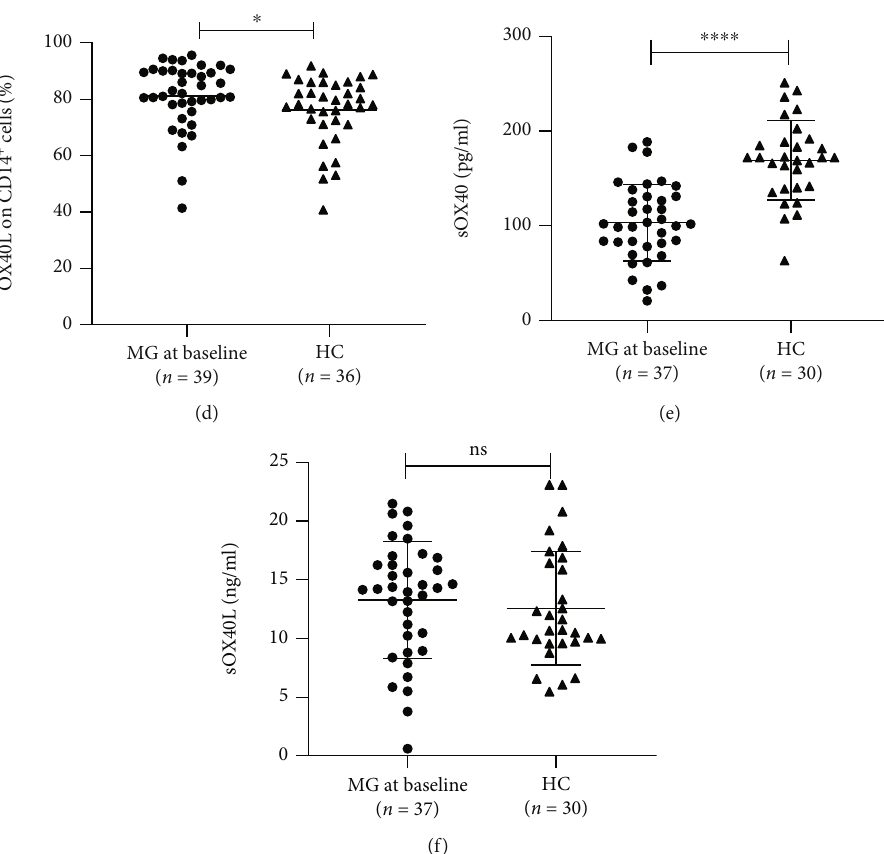
Figure 1: OX40/OX40L expression on the peripheral blood lymphocytes and plasma of patients with MG at baseline. (a) Representative expression of OX40 on CD4 + T cells and OX40L on CD19 + B cells and CD14 + mononuclear cells in the patients with MG at baseline and HC groups. The red lines indicate speci fi c staining results measured by fl ow cytometry, and the blue lines indicate isotype controls. (b) Comparison of OX40 expression on CD4 + T cells in the patients with MG at baseline and HC groups. (c) Comparison of OX40L expression on CD19 + B cells in the patients with MG at baseline and HC groups. (d) Comparison of OX40L expression on CD14 + mononuclear cells in the patients with MG at baseline and HC groups. (e) Comparison of sOX40L plasma levels in the patients with MG at baseline and HC groups. (f) Comparison of sOX40L plasma levels in the patients with MG at baseline and HC groups. Table 3: OX40 and OX40L expression in patients with MG at di ff erent stages.